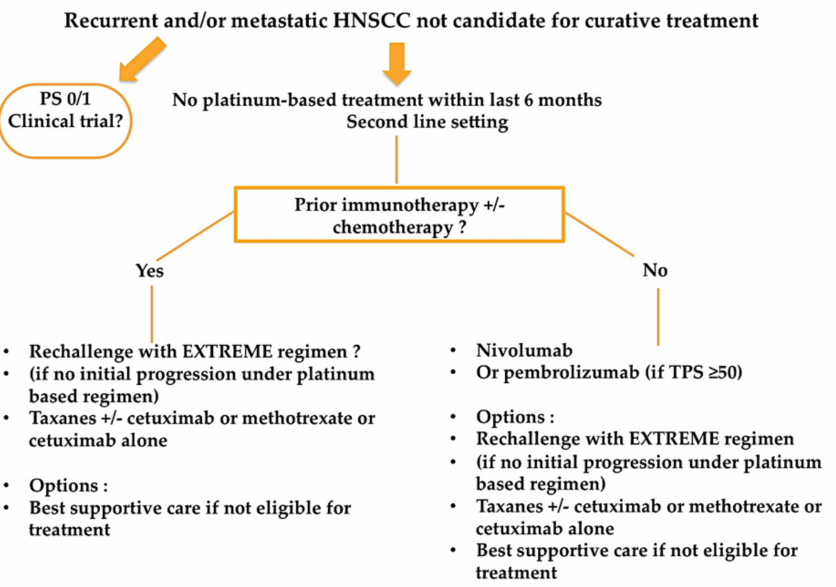
Figure 3. Proposed treatment algorithm for recurrent and/or metastatic HNSCC patients after exposure to first-line immunotherapy +/ −